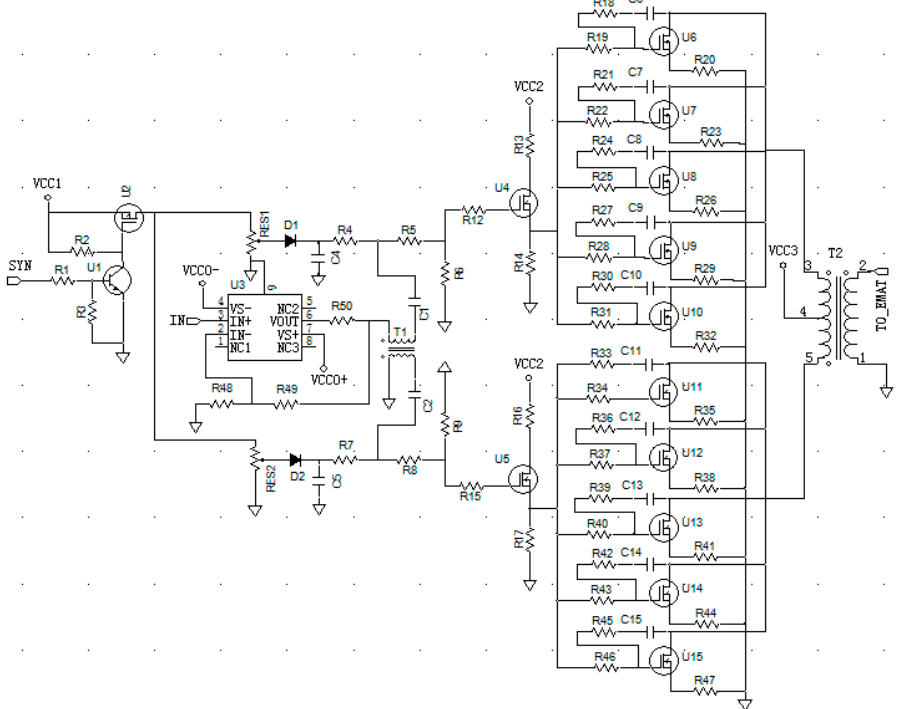
Figure 4. Proposed linear PA including two driver amplifier and ten power amplifier modules.